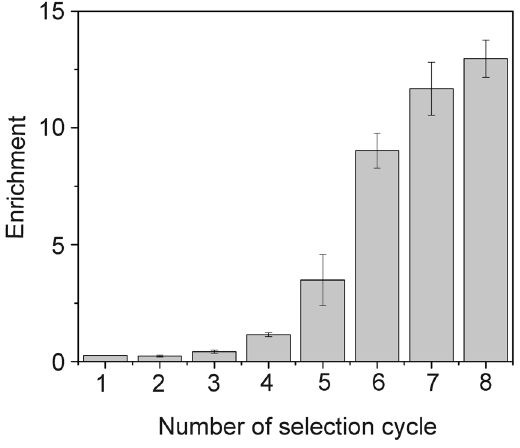
Figure 1. qPCR analysis of aptamer pool binding to R 8 -PCNA. The enrichment of aptamer pools (selection rounds 1–8) was expressed as the ratio: binding of tested aptamer pool/binding of initial ssDNA library to R 8 - PCNA. Results are the mean of three measurements. Error bars represent the standard deviation.